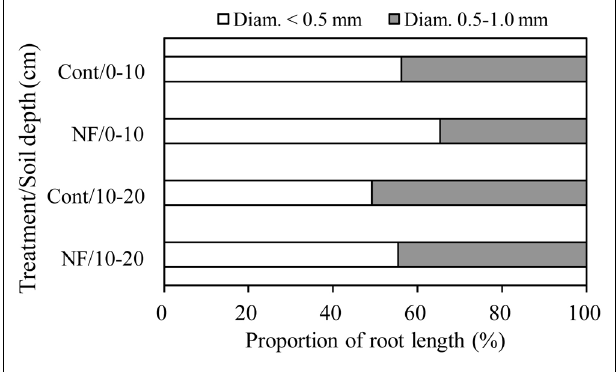
FIGURE 1 | Proportion of length of fine roots in different diameter classes. White and gray columns represent fine roots < 0.5 mm in diameter and fine roots 0.5–1.0 mm in diameter,